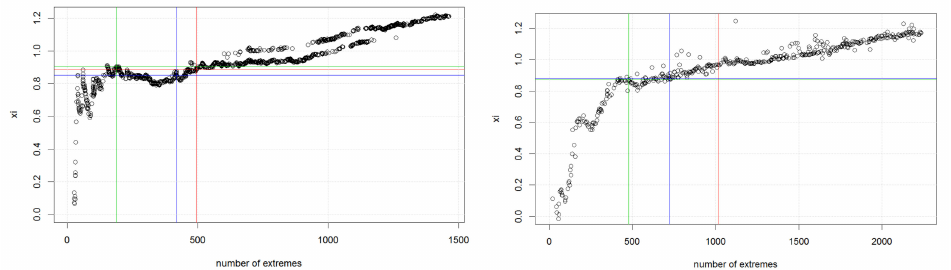
Figure A5. Plots of ξ for di ff erent thresholds (against the number of extremes used) for Salzburg and Styria (left) and (right) for all municipalities with the estimate for the 95% threshold (red), 98% threshold green and the chosen threshold (blue).